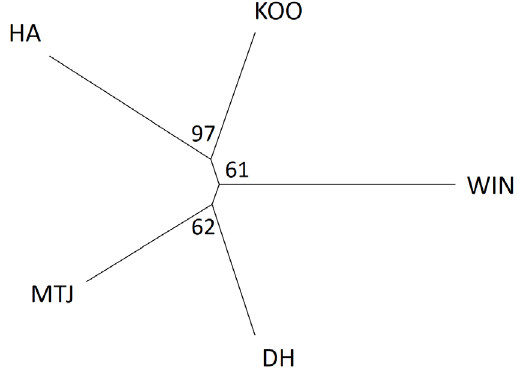
Figure 4. Unrooted neighbour-joining tree of Cavalli-Sforza chord distances between the five BIF populations of Atelomas- tix bamfordi . Distances are based on 11 microsatellite loci with bootstrap support shown at nodes.